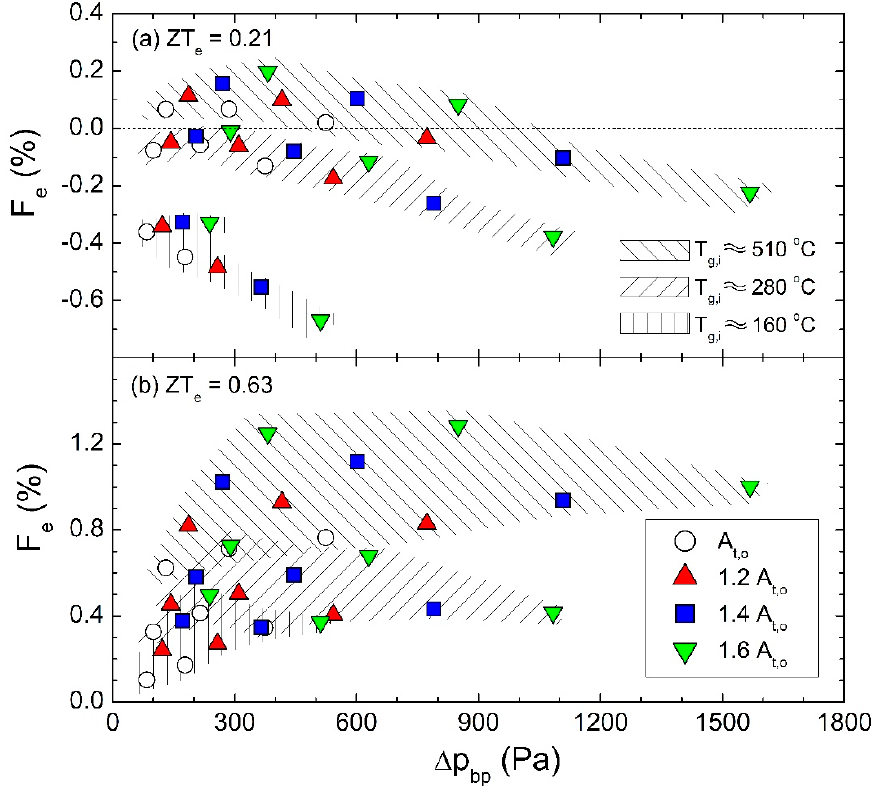
Figure 15. Fuel economy as a function of the back pressure for all cases when using TEMs with an effective figure of merit ( a ) ZT e = 0.21 and ( b ) ZT e = 0.63. Numerical results.